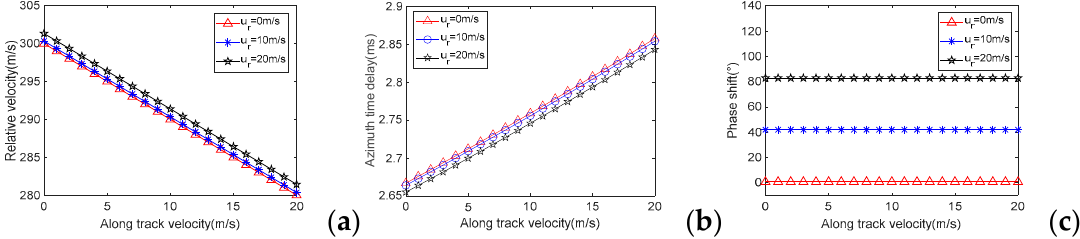
Figure 3. Effects of the along track velocity on different azimuth multichannel parameters in the multichannel GEO-SA-BiSAR system. ( a ) Relative sensor velocity. ( b ) Azimuth time delay. ( c ) Phase shift.